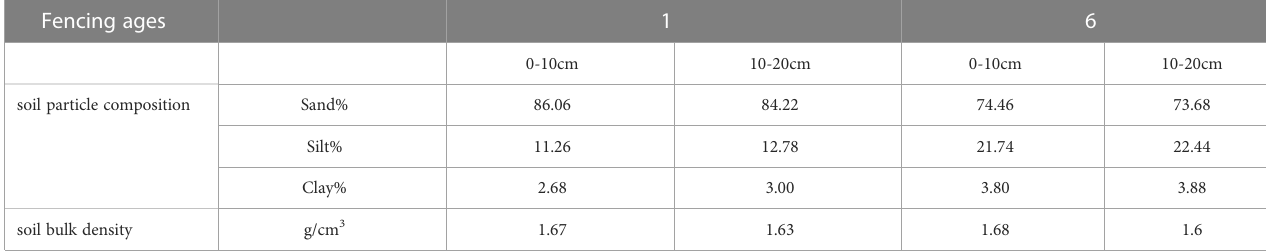
TABLE 1 Changes of soil particle composition and soil bulk density during fencing. Fencing